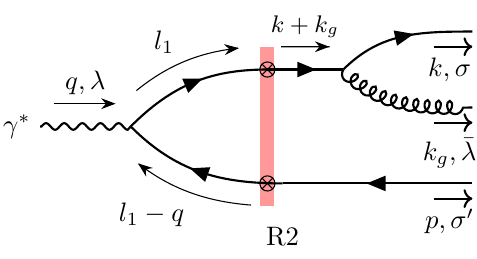
Figure 6 . Real gluon emission from the quark after scattering off the shock